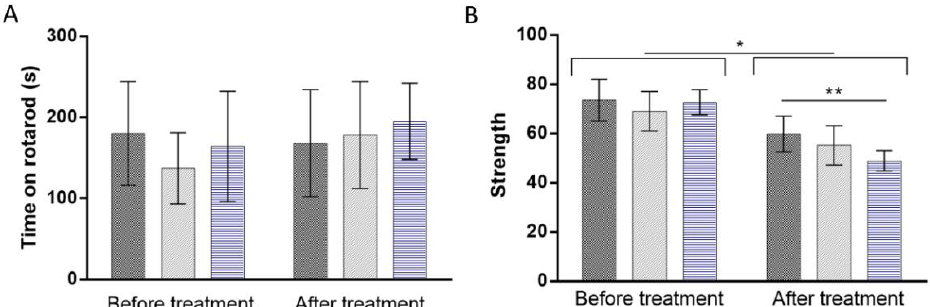
Figure 3. Effect of multi-dose administration of PBS (dark gray), neutral (light gray), and cationic liposomes (blue) on ( A ) rotarod and ( B ) grip strength performance. * p < 0.05, ** p < 0.01.